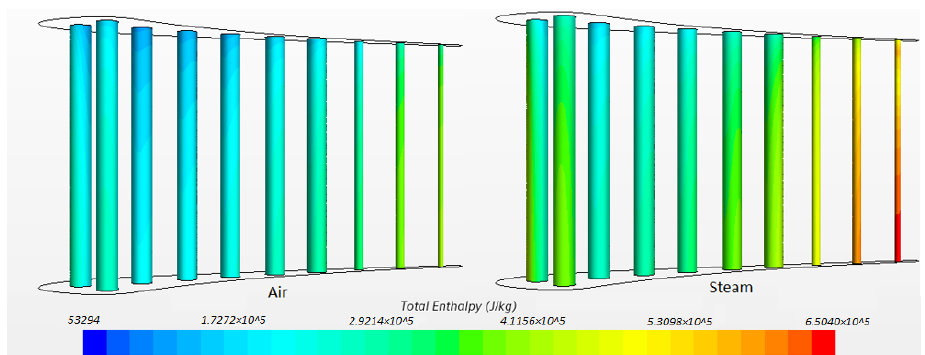
Figure 13. Pressure contours of the fluid regions in the simulations at mid-span.